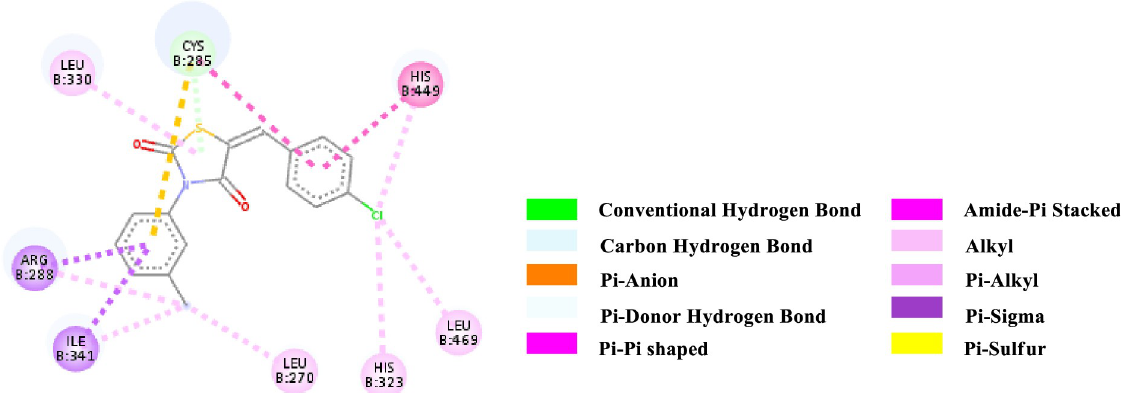
Fig 9. 2D-representation of the non-covalent interactions of 7e with receptor (3gbk) after flexible docking. https://doi.org/10.1371/journal.pone.0247619.g009 not be a good site for better binding affinity. Only exception was observed with 7a, where the methoxy group at ortho-position had no interaction with the protein. This result suggests that a good choice in a substituent may induce better binding. Compound 7e has better binding Table 3. Binding affinities and types of non-bonding interactions of the optimized ligands Epalrestat, compound 4 and 7a-e with the protein. Compounds Binding Affinity, kcal/mol Type of Non-bonding Interaction From To Bond Distance, Å